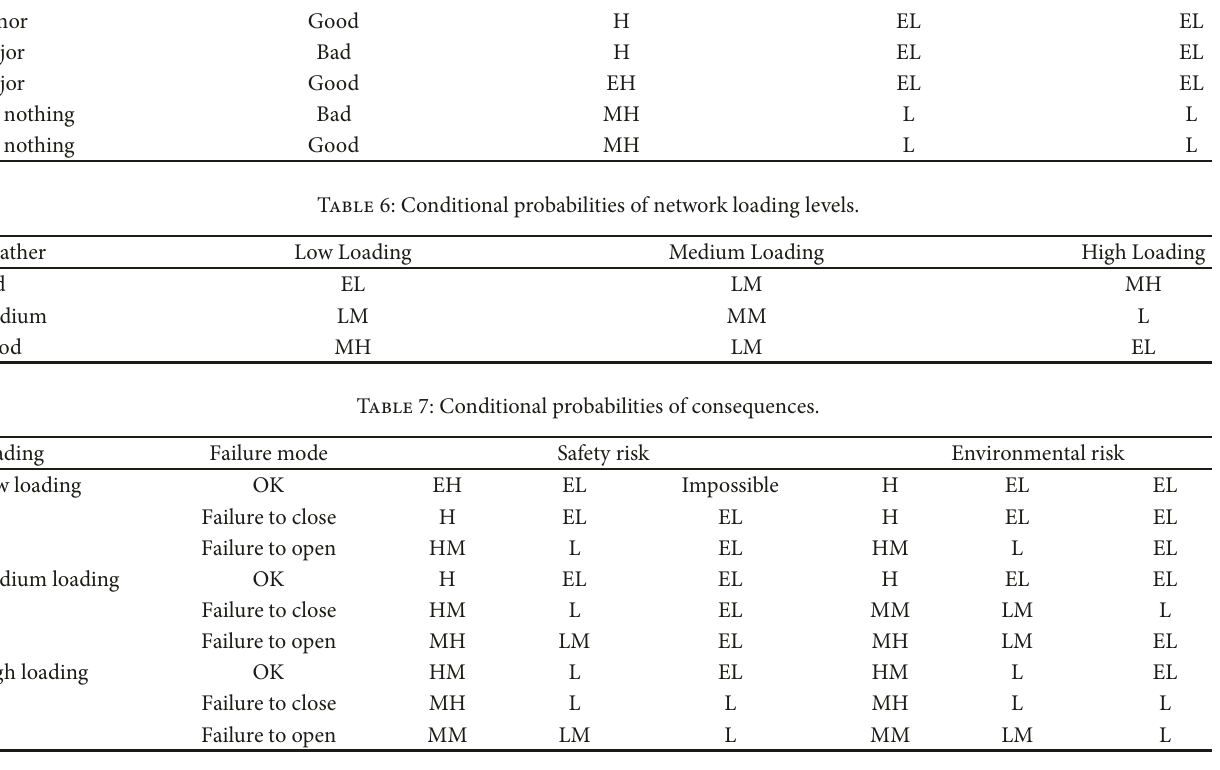
Table 8: Safety and environment criteria